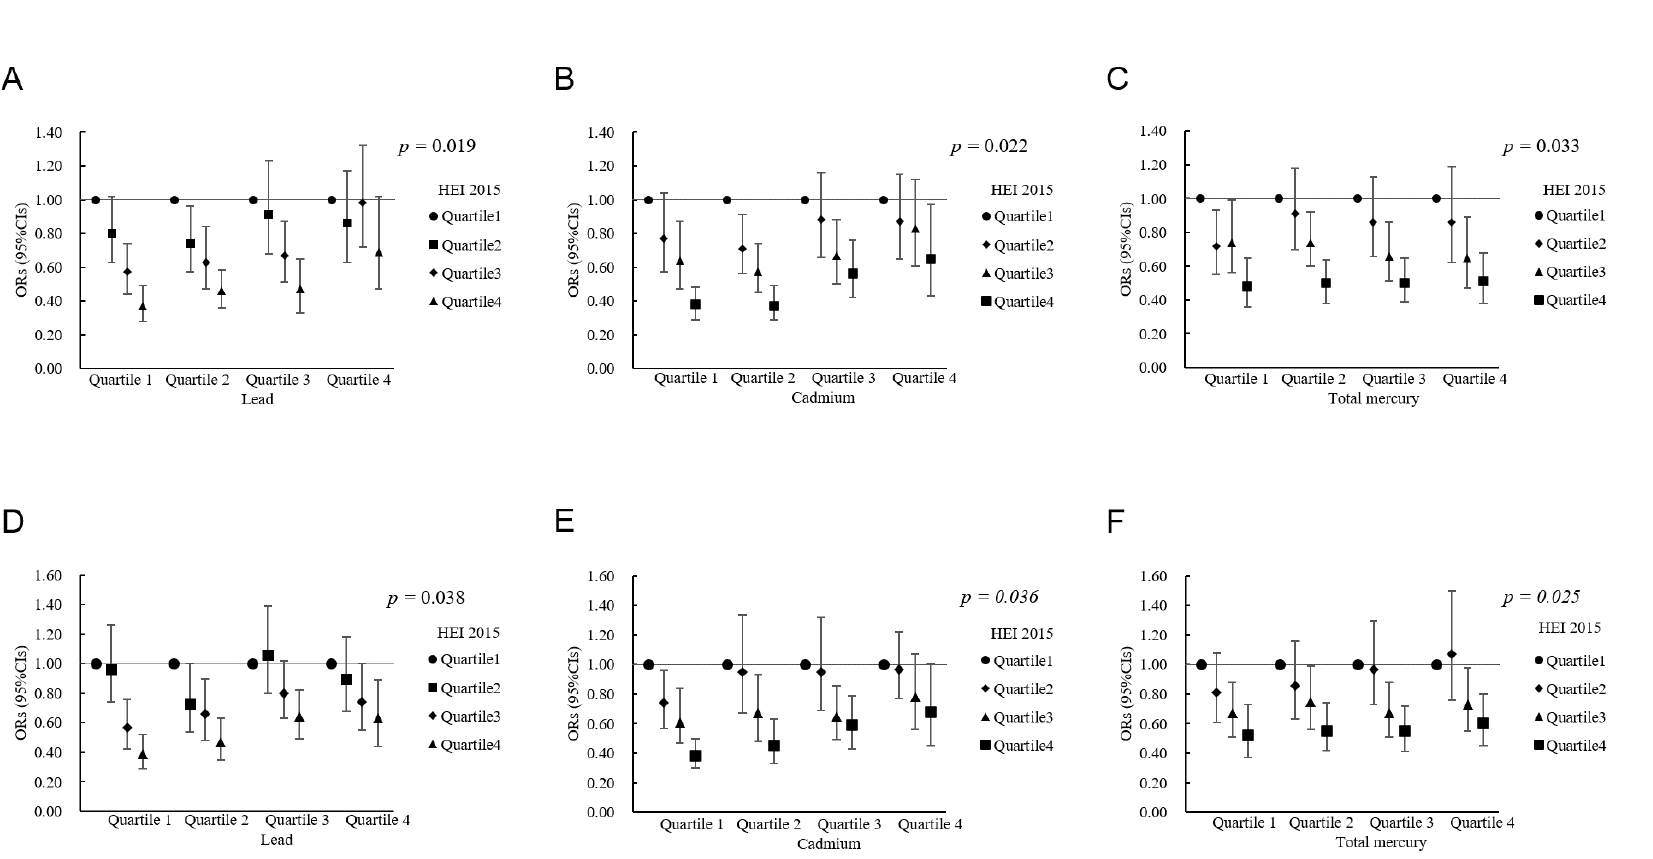
Figure 5. The association between HEI 2015 and obesity in different quartiles of heavy metals in blood. Note: ( A – C ) The association between HEI 2015 and peripheral obesity in different quartiles of lead, cadmium, and total mercury; Peripheral obesity was defined as BMI ≥ 30 kg/m 2 . ( D – F ) The association between HEI 2015 and abdominal obesity in different quartiles of lead, cadmium, and total mercury. Abdominal obesity was defined as a WC of ≥ 102 cm for males and ≥ 88 cm for females.